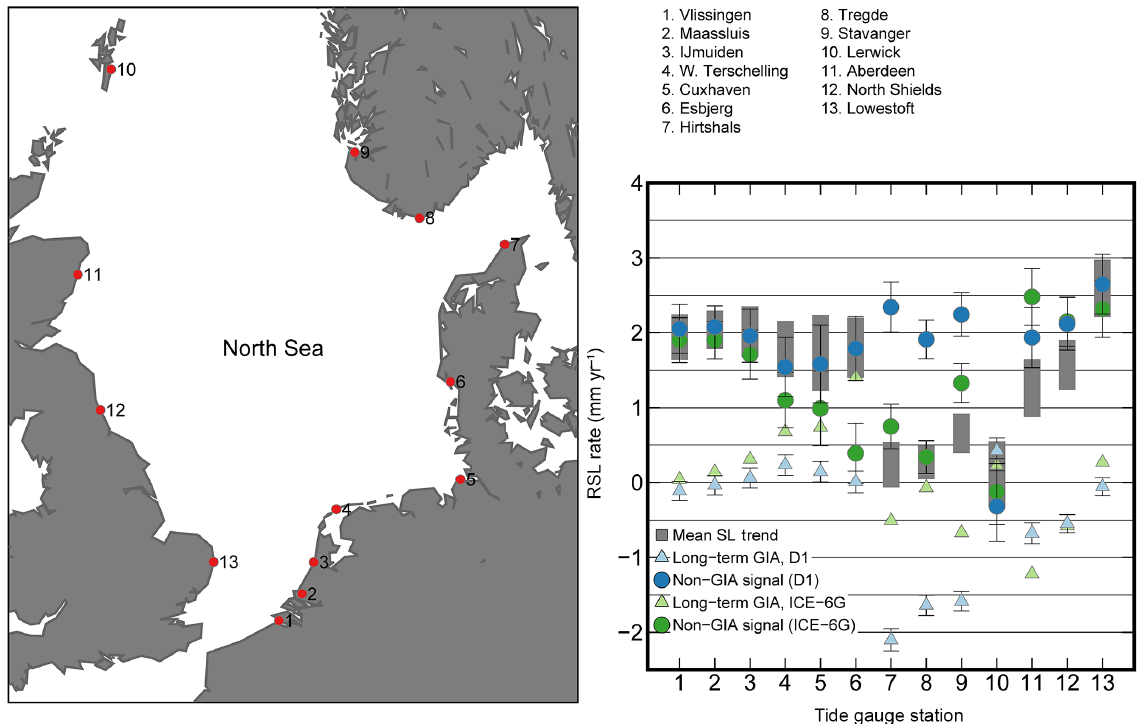
Figure 11. Comparison of mean total, long-term GIA, and non-GIA sea-level trends (grey boxes, triangles, circles) for 13 tide gauge stations in the North Sea. Long-term GIA trends are from model D1 and ICE-6G; mean sea-level trends are from Frederikse et al. (2016).